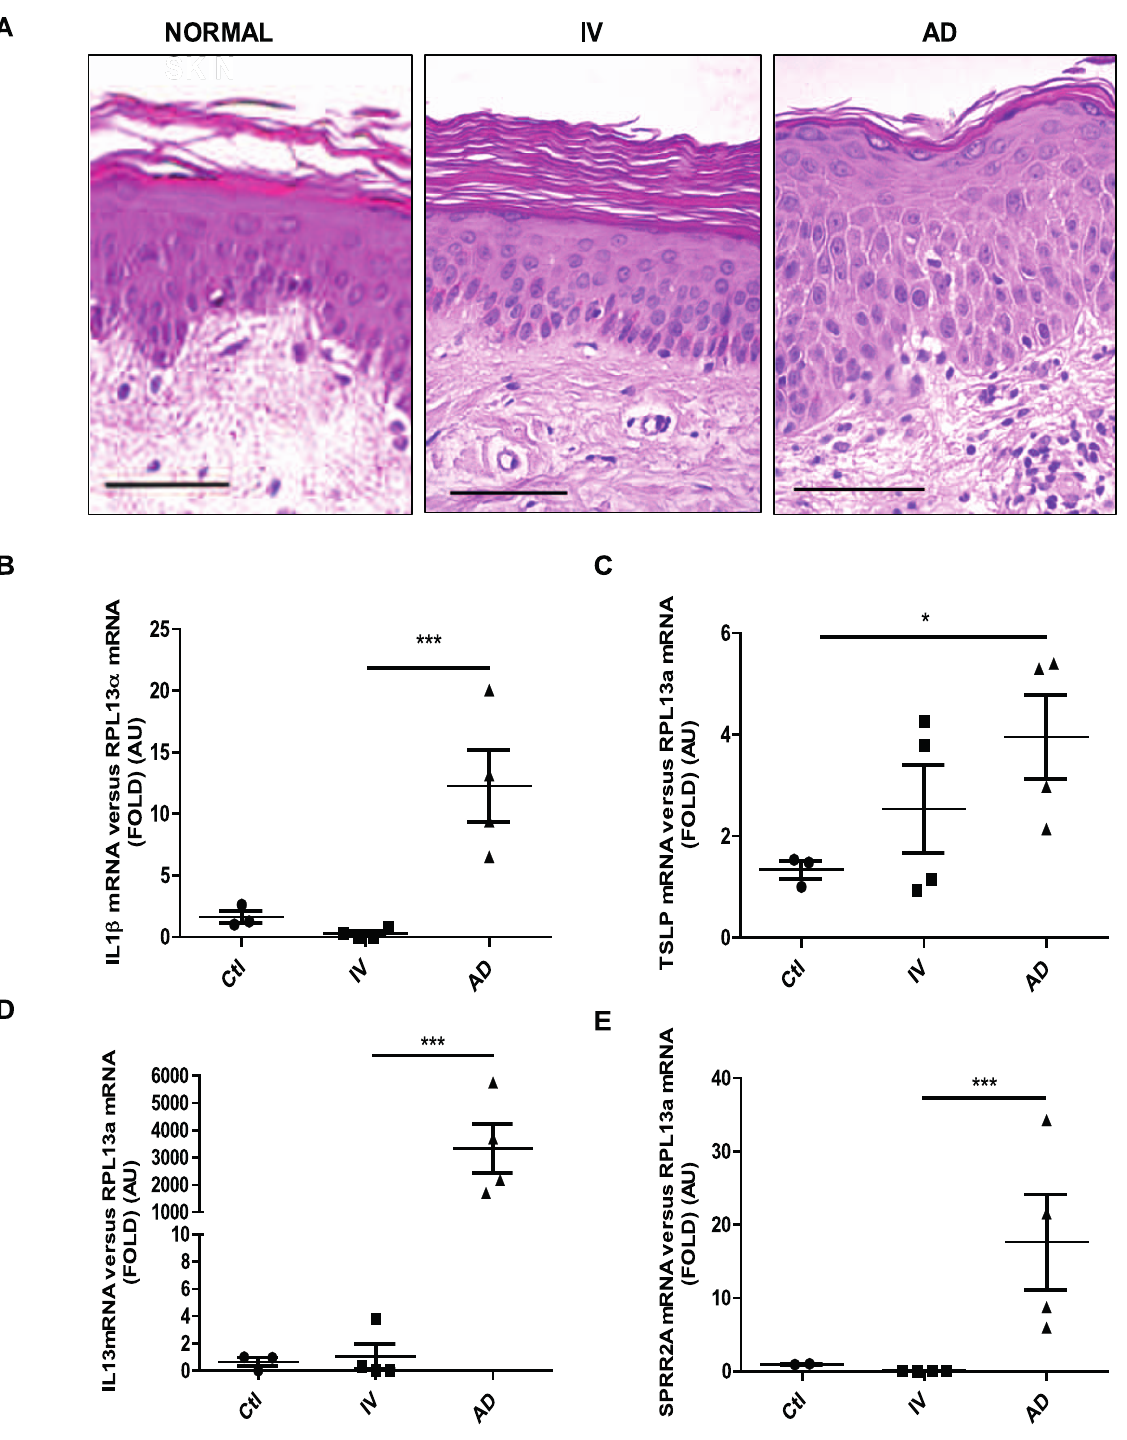
Figure 7. Comparison of healthy, IV and AD skin. A. Skin biopsies from healthy, IV and AD-patients were collected, fixed in PFA 4% and embedded in paraffin. H&E staining was performed and sections were visualized with a 20x lens. Scale bar=50 m m. B–E. cDNA were prepared from healthy, IV and AD-patient skin biopsies and real-time PCRs were performed using primers specific for (B) IL1 b , (C) TSLP (D) IL13 and (E) SPRR2a . The experiment was realized in groups of 4 patients and statistically significant differences were calculated with the student T-test (*p , 0.05 and ***p , 0.001). doi:10.1371/journal.pone.0067869.g007 Sprr2 are downstream of TSLP and/or Th2-cytokines. Therefore, overexpressing TSLP in the epidermis (K14-TSLP tg), which skin biopsies were obtained from P5 transgenic mice specifically develop a spontaneous AD [37,38]. As expected, Il4 and Il13